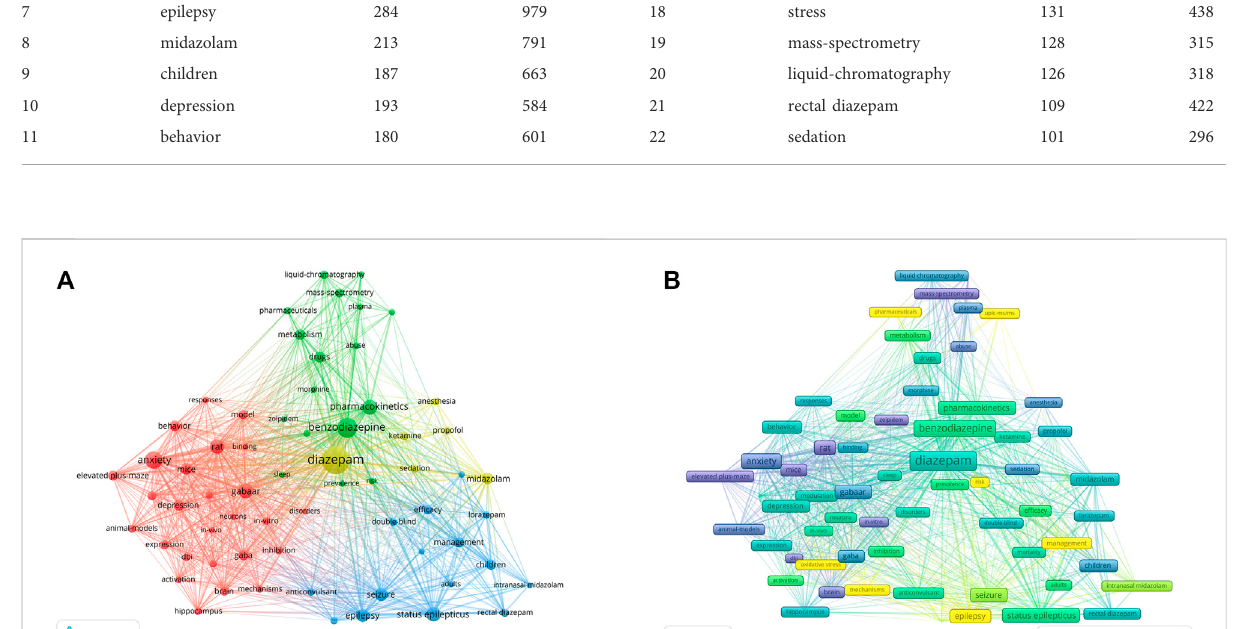
FIGURE 8 (A) Keyword co-occurrence analysis. Closely related keywords are clustered by color, and clusters of four colors (red, blue, green, yellow) represent four clusters. (B) Overlay visualization map of keyword co-occurrence analysis. Nodes marked in purple or blue indicate keywords that appear relatively early, while keywords marked in yellow indicate current research